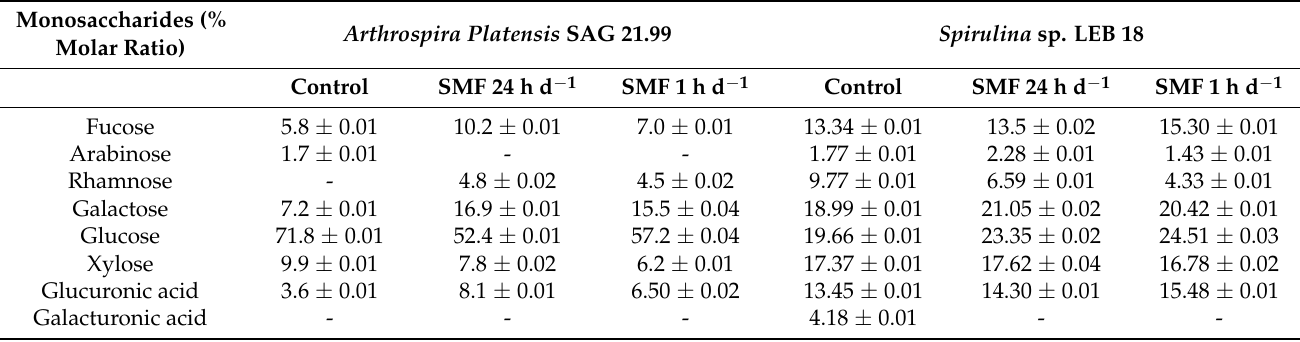
Table 3. Monosaccharide composition of EPS from cyanobacteria strains cultivated under different conditions of SMF application. Monosaccharides (% Molar